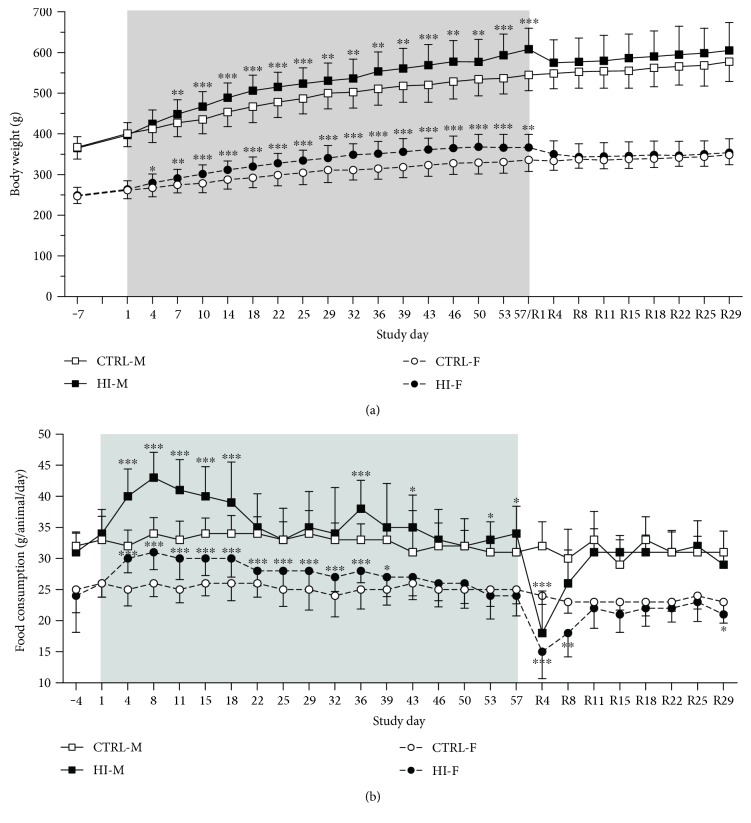
(a) Body weight, group mean + SD. (b) Food consumption, group mean + SD. Grey areas indicate infusion period. Days −7 to 29: n = 32 − 38/group per time point, days 32–57: n = 20 − 28/group per time point (except for days 53 and 57 for group HI-M, where n = 15 − 17/time point), and days R4–R29: n = 5 − 10/group per time point. ∗p < 0.05, ∗∗p < 0.01, and ∗∗∗p < 0.001 versus controls.